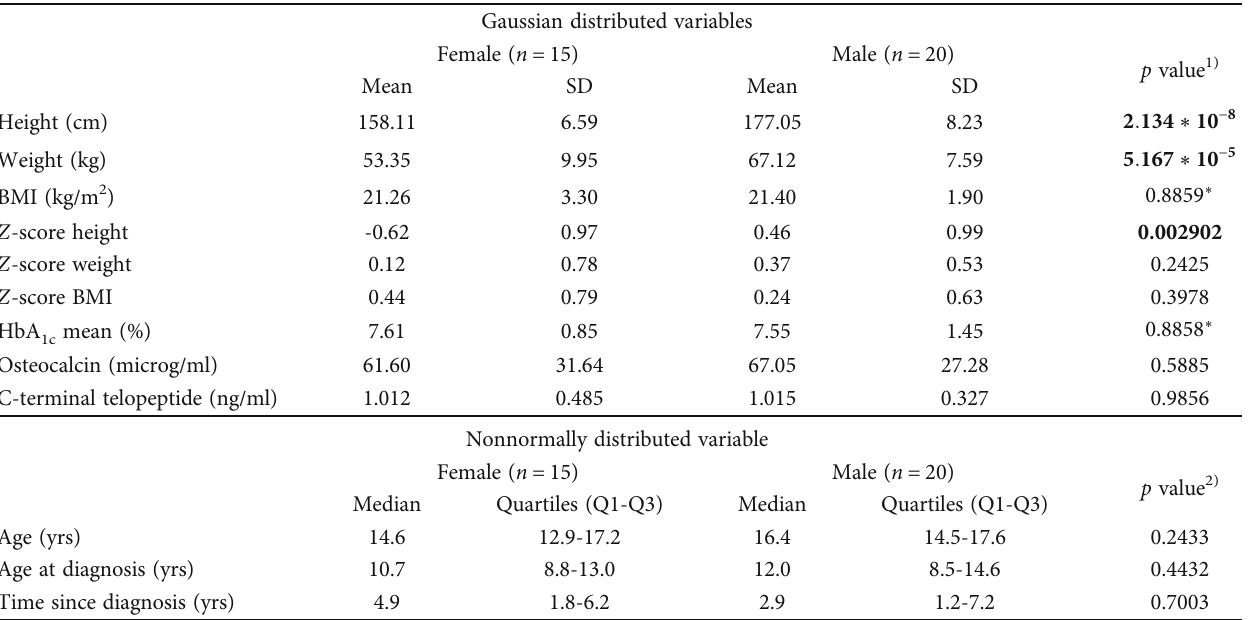
Table 1: Characteristics of the studied group by sex.